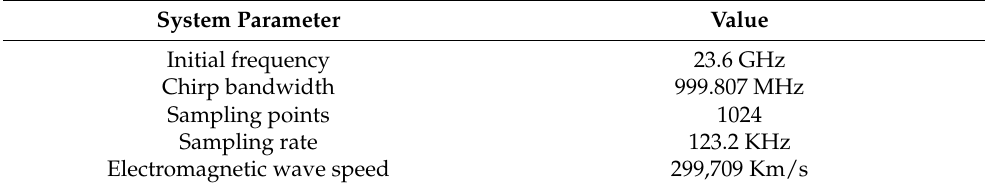
Figure 5. Test system for FMCW radar. Table 4. Parameters of the FMCW test